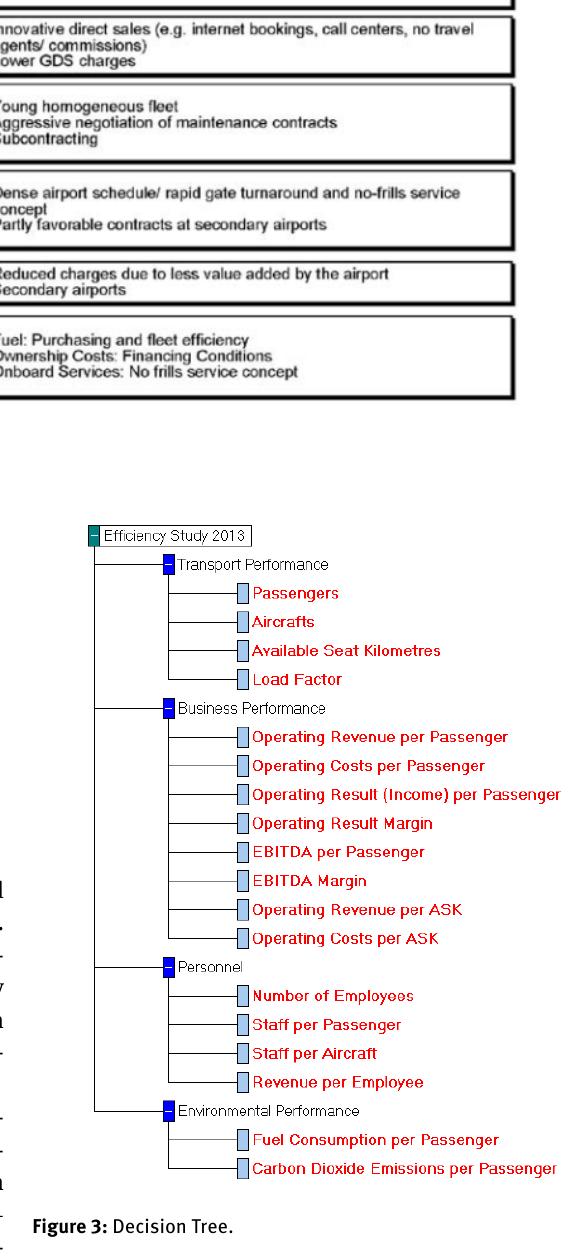
Figure 3: Decision